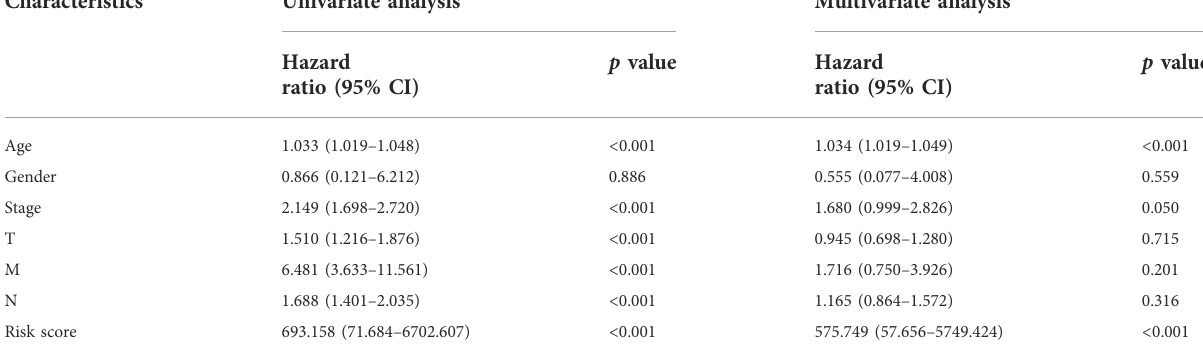
TABLE 4 Univariate and Multivariate analysis of m7G-LPS and clinicopathological